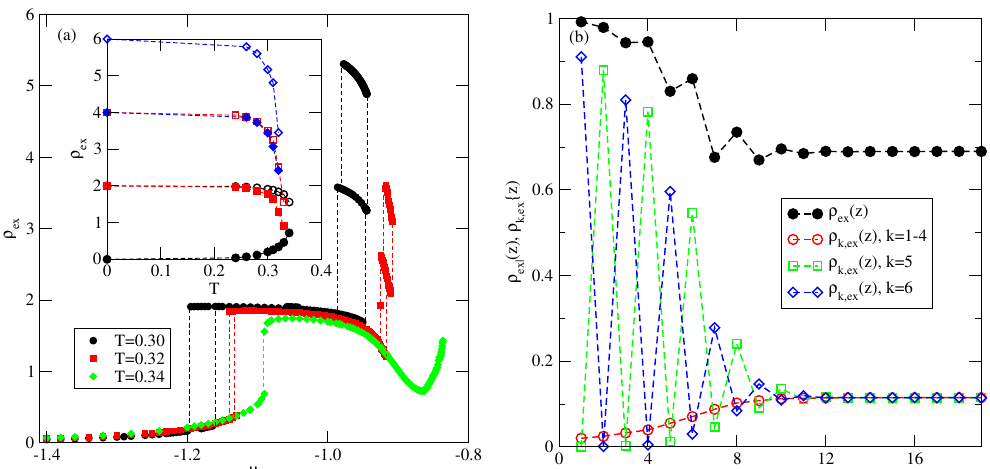
Figure 16. ( a ) The excess adsorption isotherms for the system with V o = − 0.4. The inset shows the estimated ( ρ , T ) projection of the phase diagram. ( b ) The profiles ρ ( z ) and ρ k ( z ) , recorded at T = 0.34 and µ = 0.836.